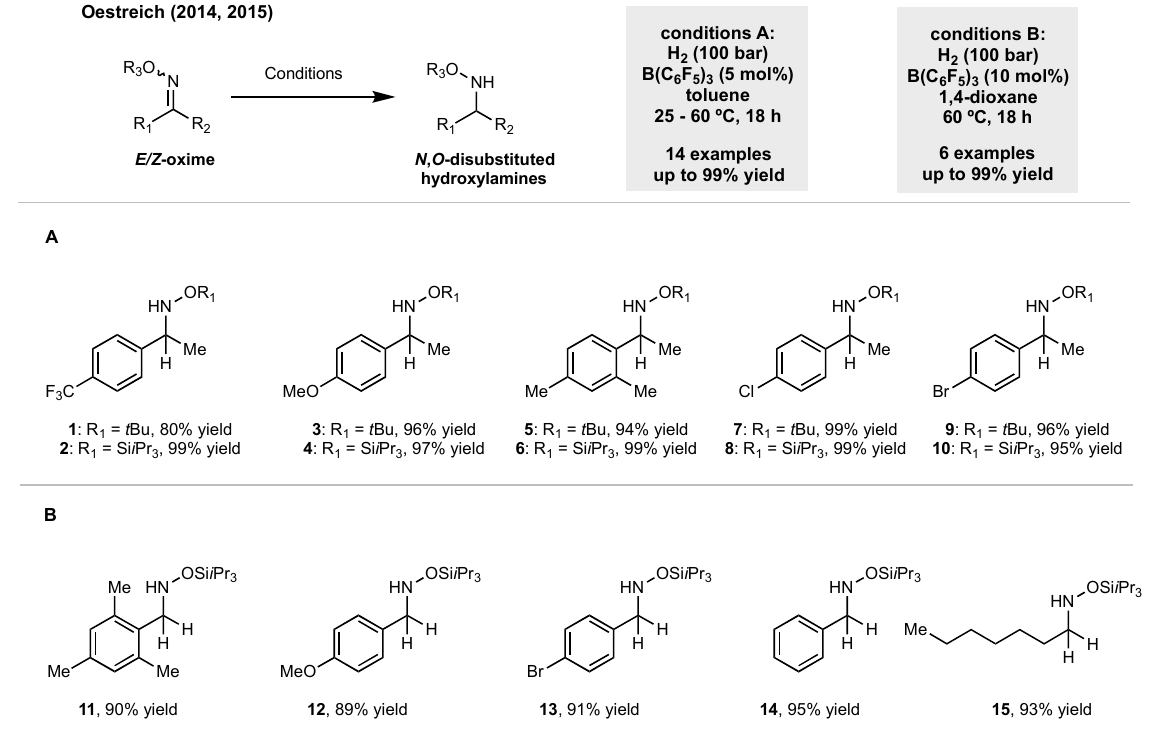
Scheme 1. Oestreich(cid:31)s hydrogenation of E / Z oximes using frustrated Lewis pairs. ( A ) Selected ex- Scheme 1. Oestreich’s hydrogenation of E / Z oximes using frustrated Lewis pairs. ( A ) Selected examples of the reaction on ketoximes using conditions A. ( B ) Selected examples of the reaction on aldoximes using conditions B